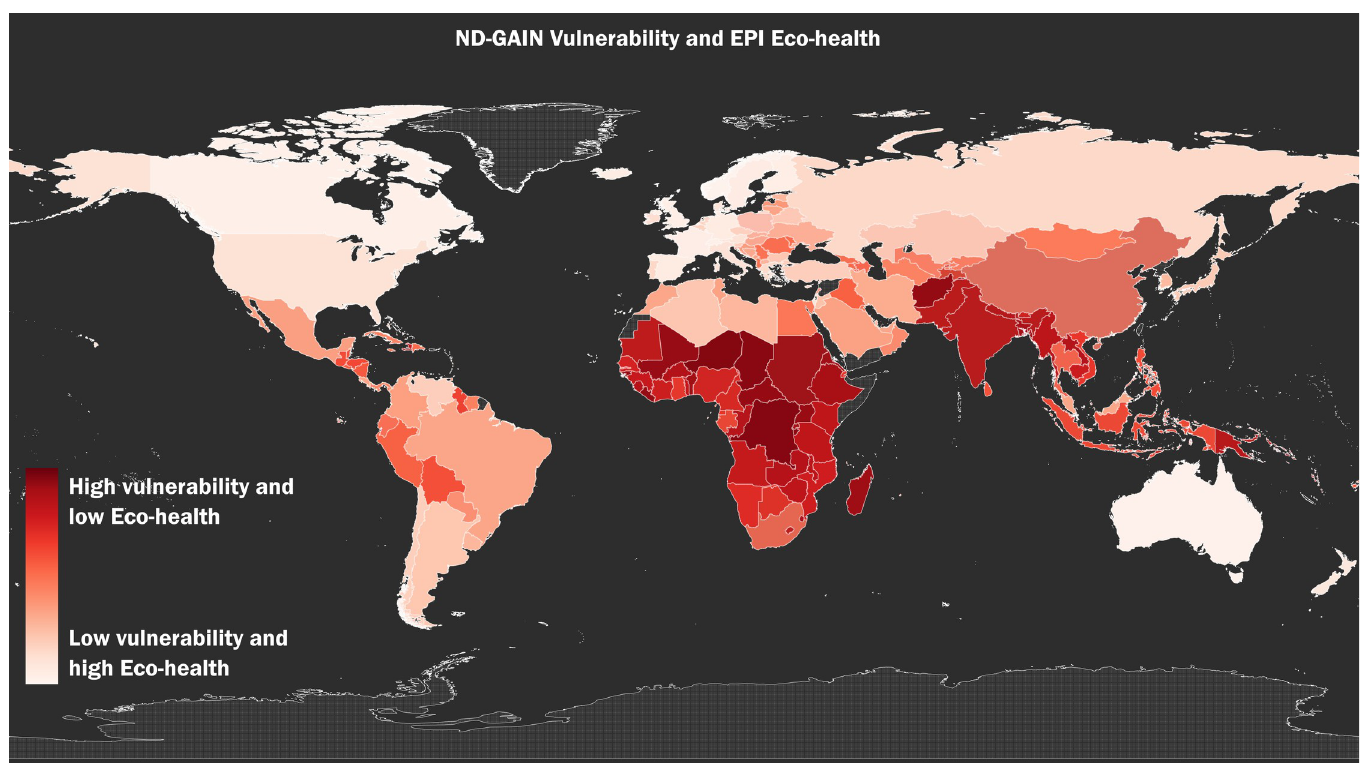
Fig 4. The global distribution of the combined toxic-climate risk. The global distribution of the combined risk of toxic pollution (low or high ecosystem health) and climate impacts (high or low vulnerability) risk using the average of the by-country rank-order of Vulnerability and Eco-health .